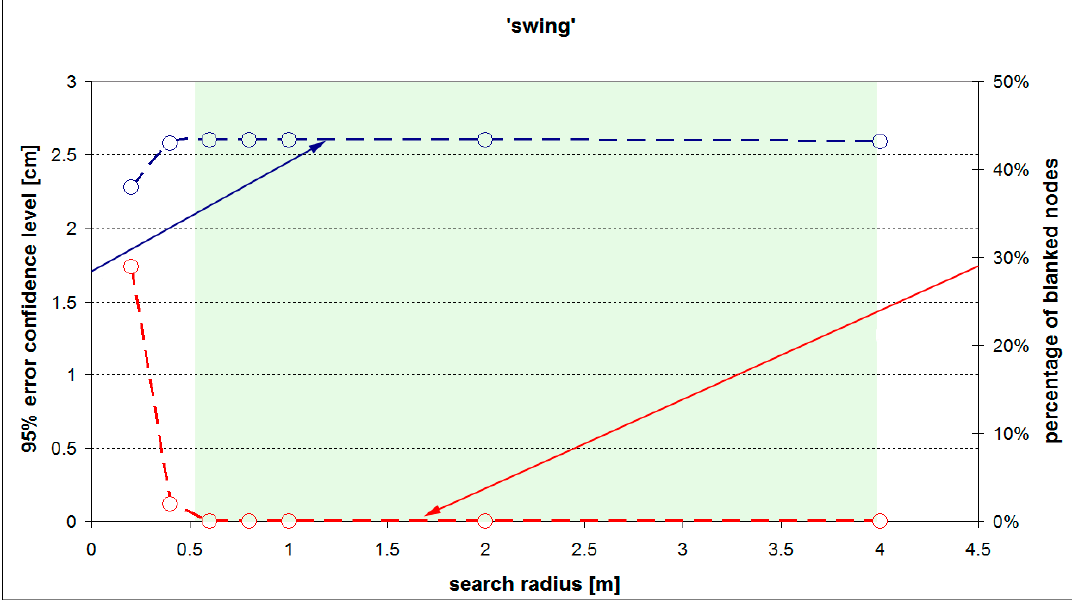
Figure 5. The results for ‘wrecks’ surface with different search radius values. Figure 5 (surface ‘ wrecks ’) presents that the 95% confidence level of error rate increase from the value 1.4 cm to 3.1 cm. The percentage of blank nodes falls from 43% at 0.1 m and it stabilised at 0% (for radius = 0.4 m and more). Consequently, the value of optimal search radius for this surface equal to 0.2 m was chosen. Given all the obtained results for all three surfaces it is easy to notice, that the smaller radius was used, the better the accuracy of created model is. On the other hand, for the smallest values of radius,